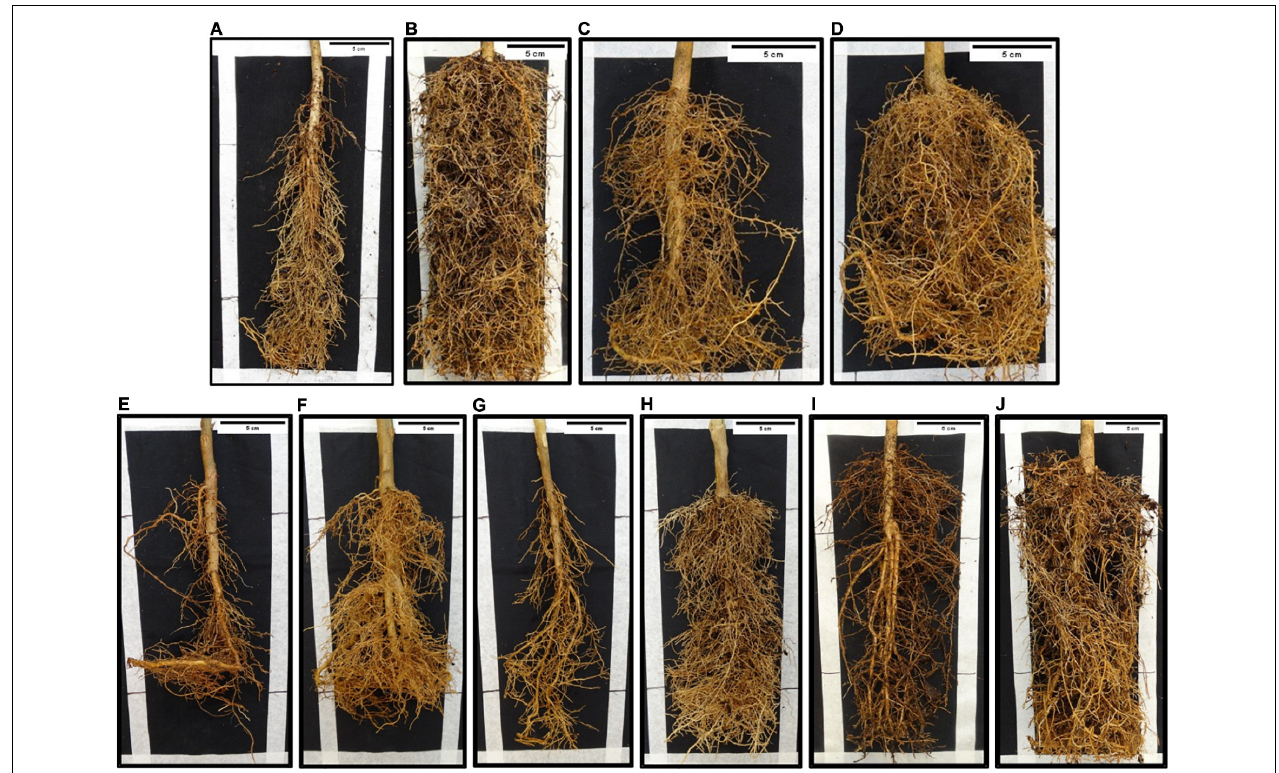
FIGURE 3 | HLB-like symptoms in roots from ‘Rangpur’ lime rootstocks graft-inoculated either with Las-infected or healthy control budwood in composite plants with infected vs. healthy control scions from three susceptible, the partially resistant Microcitrus australasica and the full-resistant E. glauca × C. × sinensis genotypes at 12 months after challenge-inoculation. (A) Citrus × sinensis ‘Pera’, Las-infected; (B) C. × sinensis ‘Pera’, control; (C) C. × sinensis ‘Tobias’, Las-infected; (D) C. × sinensis ‘Tobias’, control; (E) Atalantia citroides , Las-infected ; (F) Atalantia citroides , control ; (G) Microcitrus australasica , Las-infected; (H) Microcitrus australasica , control; (I) E. glauca × C. × sinensis hybrid, Las-inoculated; (J) E. glauca × C. × sinensis hybrid,